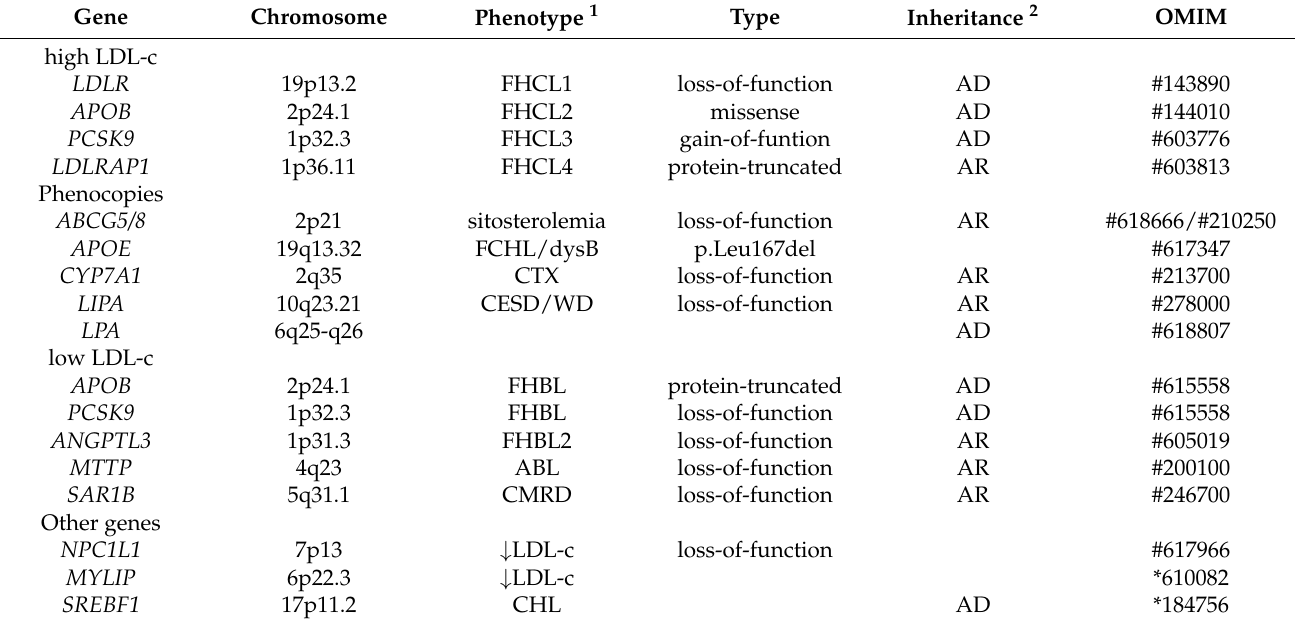
protein-truncated mutations of the low-density lipoprotein receptor adaptor-protein 1 gene ( LDLRAP1 ) [19]—a cytosolic protein that interacts with the cytoplasmatic tail of the LDLR. Table 1. Genes associated with primary monogenic dyslipidemias related to plasma LDL-c levels.